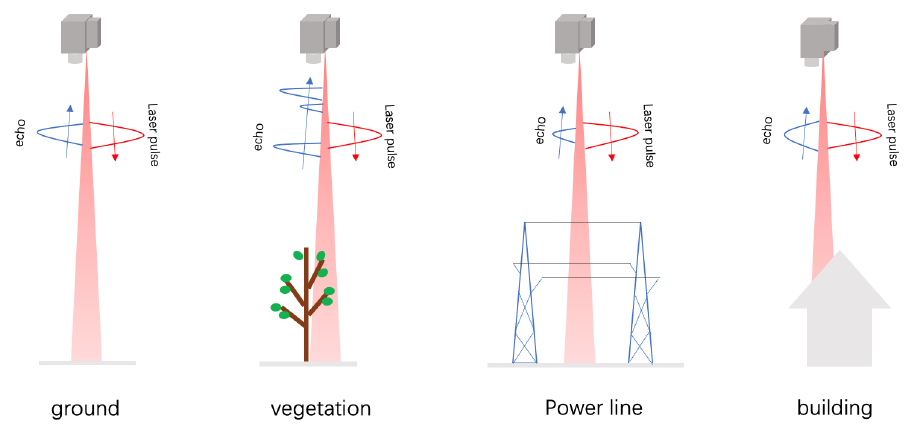
Figure 1. Schematic diagram of echo under urban